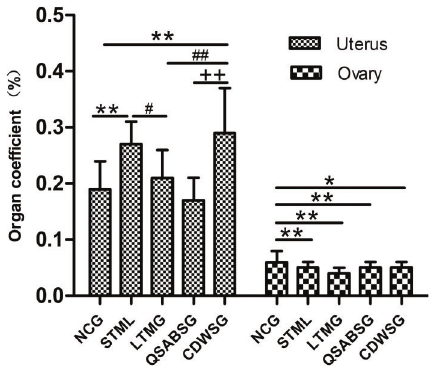
Figure 3. E ffect of treatment on organ coef fi cients of the uterus and ovary. Data are reported as means ± SD. *P o 0.05, **P o 0.01 compared with NCG; # P o 0.05, ## P o 0.01 compared with LTMG; ++ P o 0.01 compared with QSABSG (ANOVA). NCG: normal control group; STMG: short-term model group; LTMG: long- term model group; QSABSG: Qi stagnation and blood stasis group; CDWSG: combining disease with syndrome group.